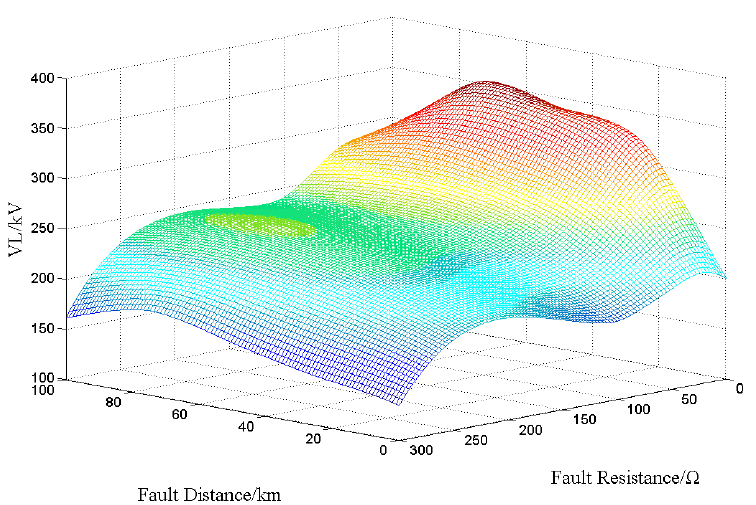
Figure 19. The maximum value of V L when positive pole-to-ground fault in different positions through different fault resistance.